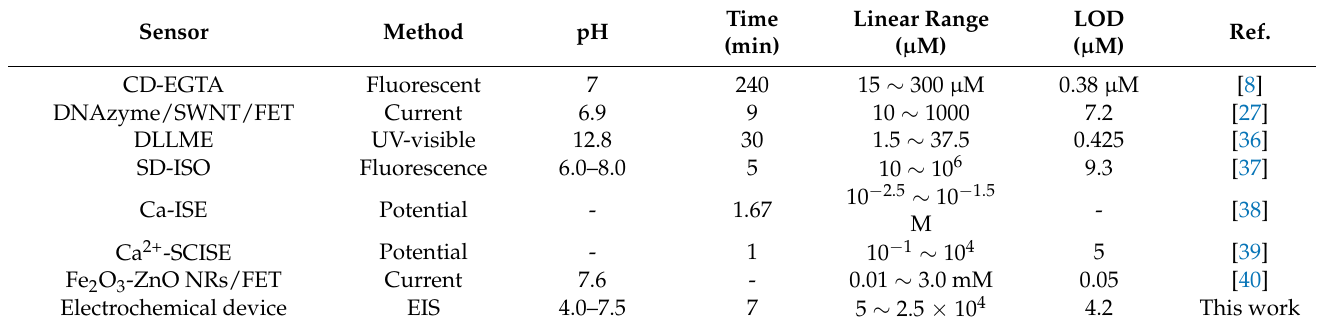
Table 2. Comparison of the performances of electrochemical device and other reported sensors for Ca 2+ determination.